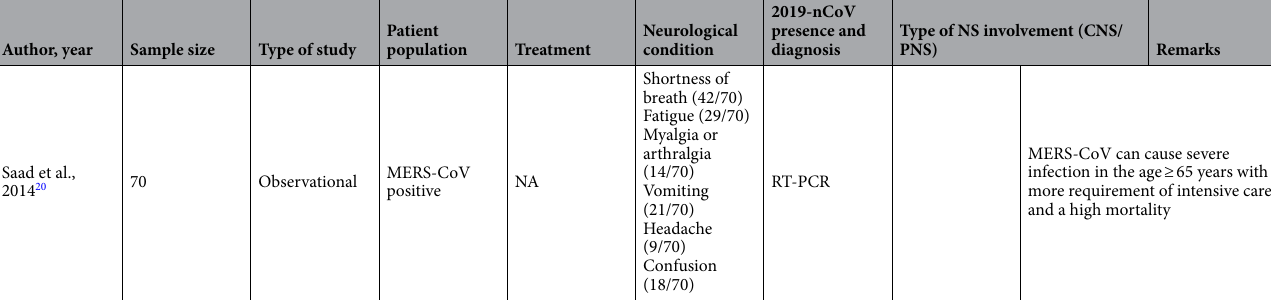
Table 3. Published case reports of previous SARS-CoV and MERS patients of neurological manifestations/ outcomes. NA not available, RT-PCR real-time polymerase chain reaction, CSF cerebrospinal fluid, GTC